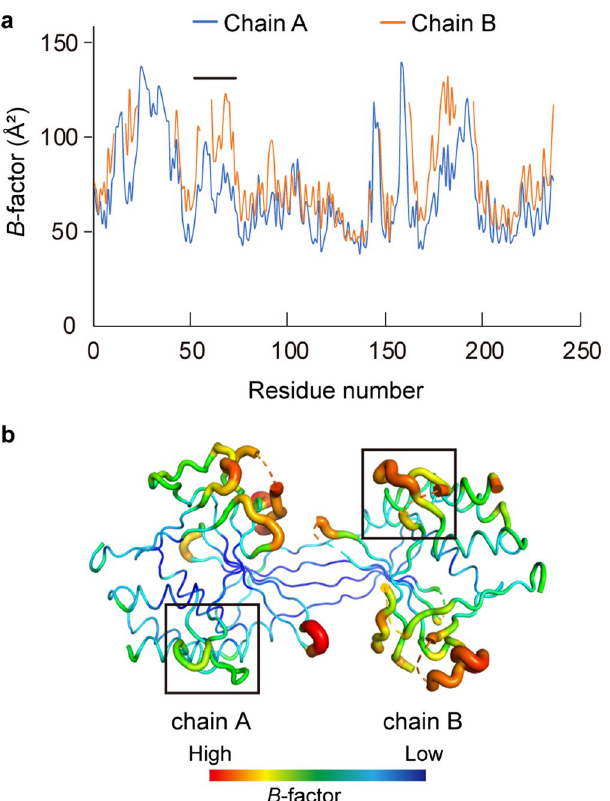
Figure 6. Temperature factor of R.CcoLI. ( a ) Plot of the average B -factor of each residue. The position of the characteristic antiparallel β-sheet region is indicated by a black line. ( b ) The R.CcoLI structure is colored according to the B -factors. The positions of the characteristic antiparallel β-sheet regions are indicated by black